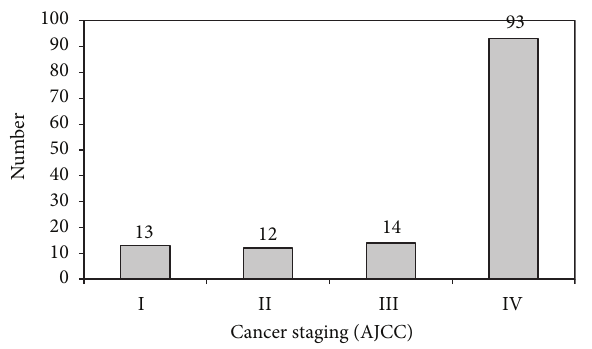
Figure 3: Staging of head and neck carcinomas according to the American Joint Committee on Cancer